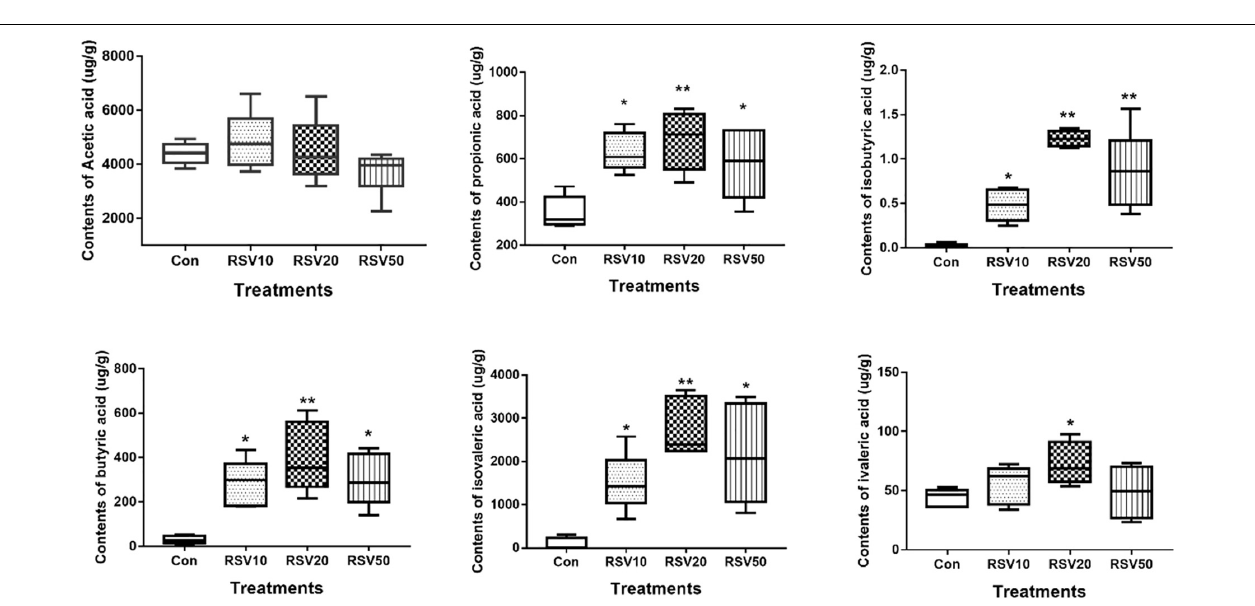
FIGURE 5 | Effect of RSV on the expression of AMP genes in the ileum of weaned mice. The relative mRNA expression of AMP related genes was detected by qRT-PCR. Con = control group, RSV10 = 10 mg/kg RSV, RSV20 = 20 mg/kg RSV, RSV50 = 50 mg/kg RSV. *Means with single asterisks are significantly different ( p < 0.05) from values of control group, and all the data are expressed as the means ± SEM.